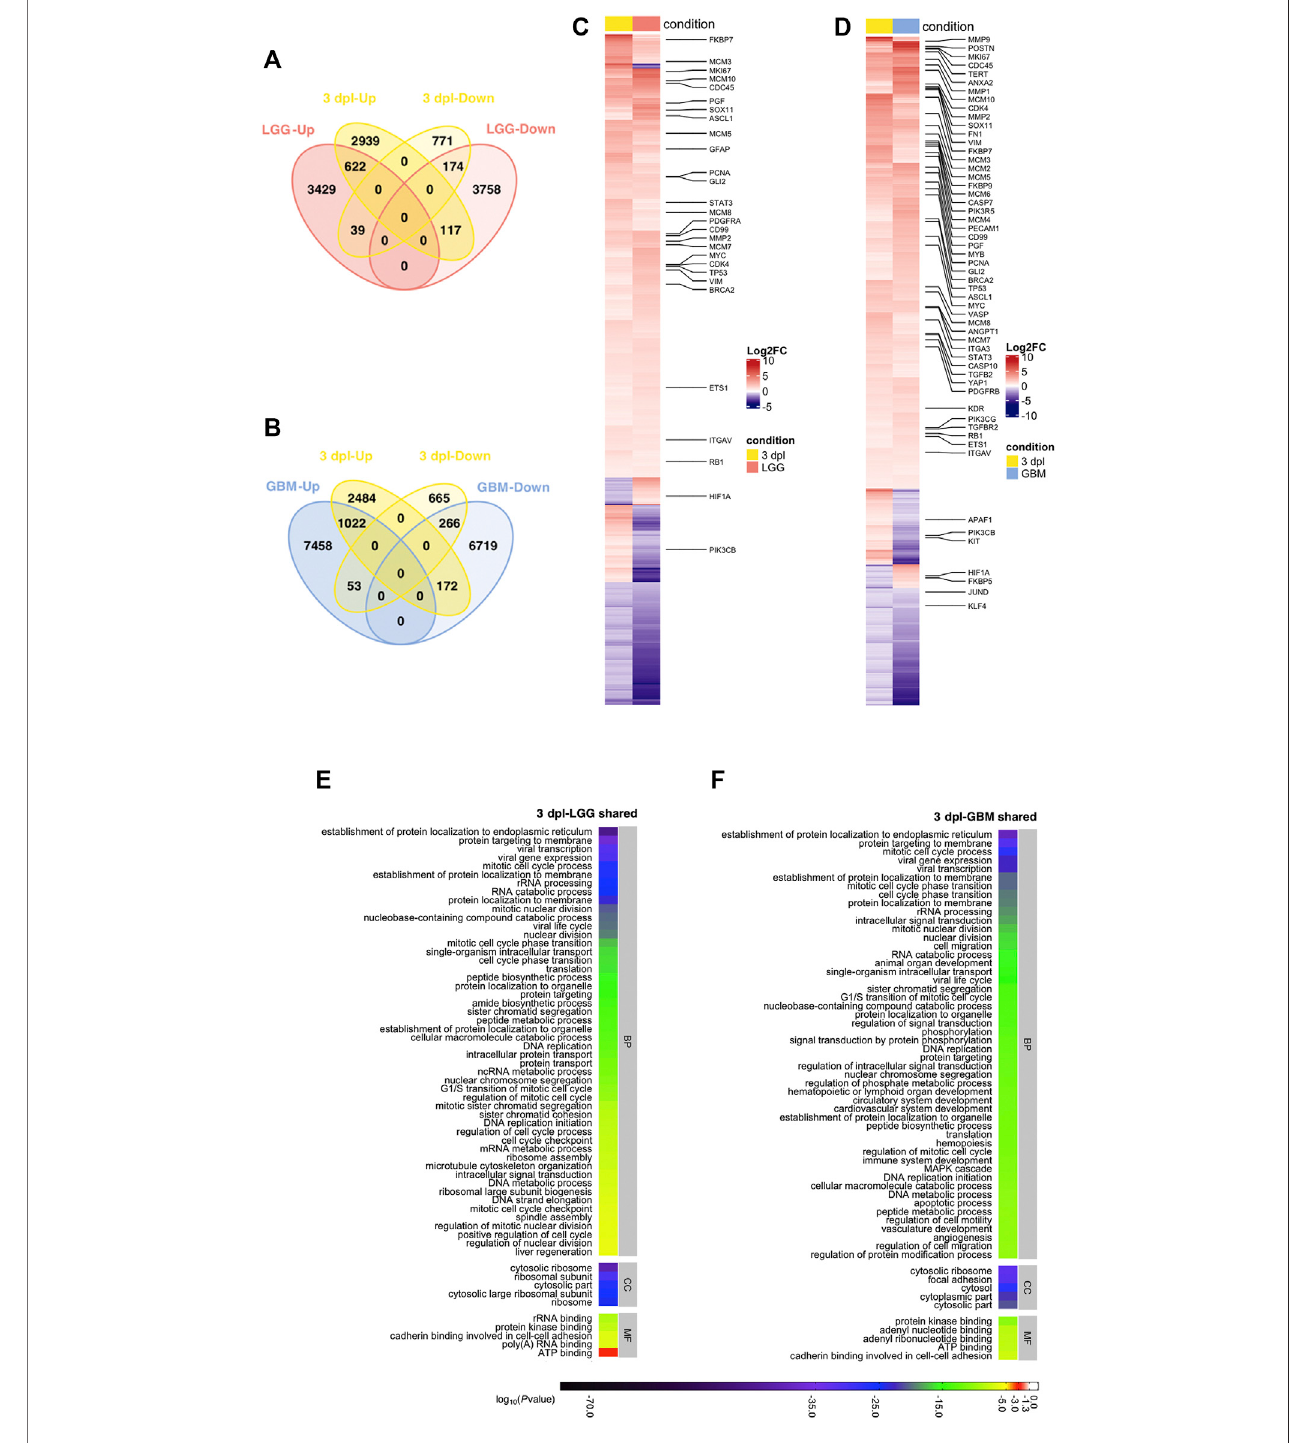
FIGURE5 | Early proliferative stage (3 dpl) ofbrain regeneration resembles brain cancer withregardtoactivation ofcell proliferation. (A,B) Venn diagrams showing thenumberofupregulated(Up)ordownregulated(Down)DEGsandtheoverlapbetween3dpl(yellow)and (A) LGG(pink)and (B) GBM(blue). (C,D) Heatmapsshowing the expression of genes shared between 3 dpl (yellow) and (C) LGG (pink) and (D) GBM (blue). Each column represents a condition (3 dpl, LGG or GBM) and each row shows a single gene. The scale bar shows log 2 fold changes from high to low regulation, represented by a color gradient from red to purple, respectively. (E,F) DAVIDwasused toshow themost signi fi cantlyenriched GO-BP (top 50), CC (top 5), and MF (top 5) terms based on transcriptional changesin comparison of3 dpl with (E) LGGand (F) GBMbyusinghumanidenti fi ersofshared DEGs.Theheatmapscaleshowslog 10 oftheease p -valuesforthemostsigni fi cantlyenrichedGOterms.dpl: days post-lesion, DAVID: database for Annotation, Visualization and Integrated Discovery, GO: Gene Ontology, BP: Biological Process, MF: Molecular Function, CC: Cellular Component, dpl: days post lesion, LGG: low-grade glioma, GBM: glioblastoma.